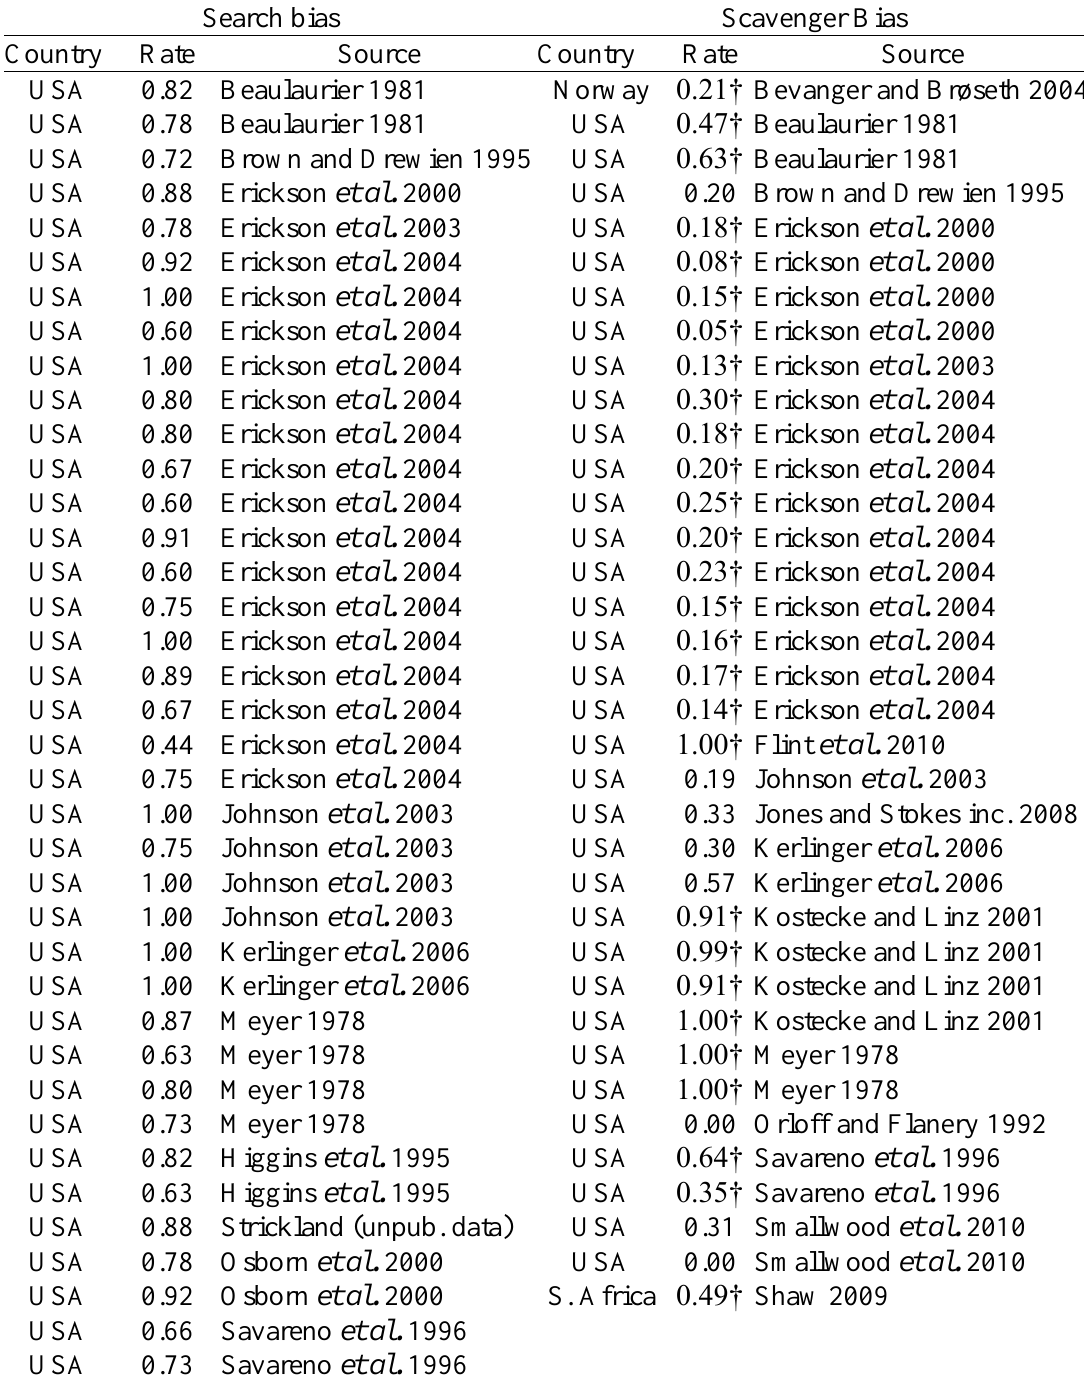
Table A2.4. Search and scavenger bias values used to calculate standardized mortality rates. Search bias is referred as the percentage of planted birds founds by observers. Scavenger bias rates are expressed as the percentage of carcasses remaining after 7